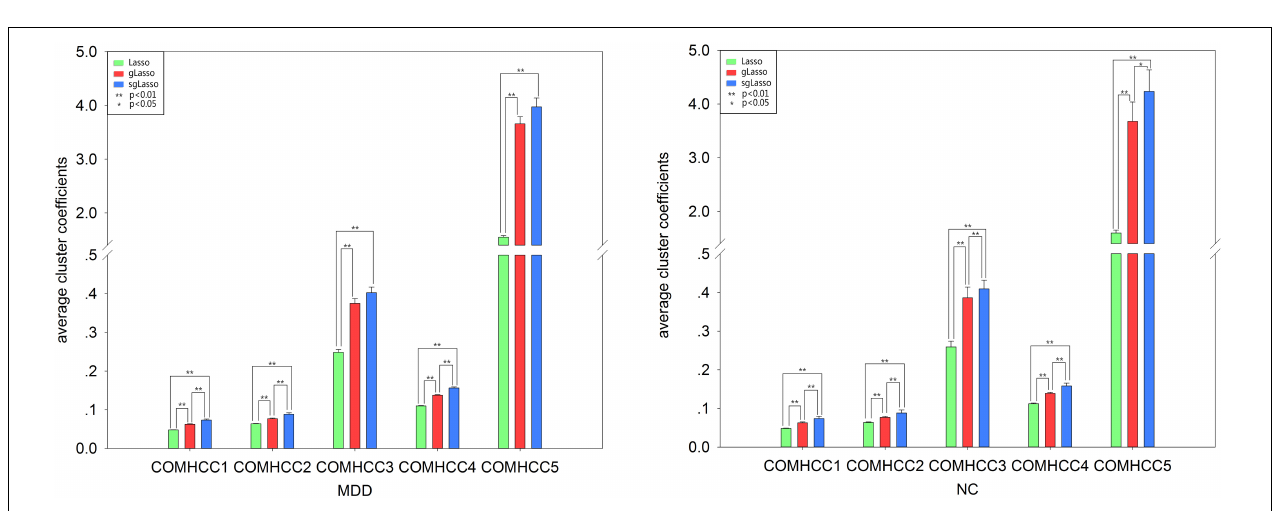
FIGURE 3 | Comparison among three hypernetworks based on three kinds of average clustering coefficient for HCC properties. Error bars indicate standard deviation. Asterisks represent a significant difference; * p < 0.05, ** p < 0.01. Green histograms denote lasso method; Red histograms denote gLasso method; Blue histograms denote sgLasso method. NC, normal control; MDD, major depressive disorder.